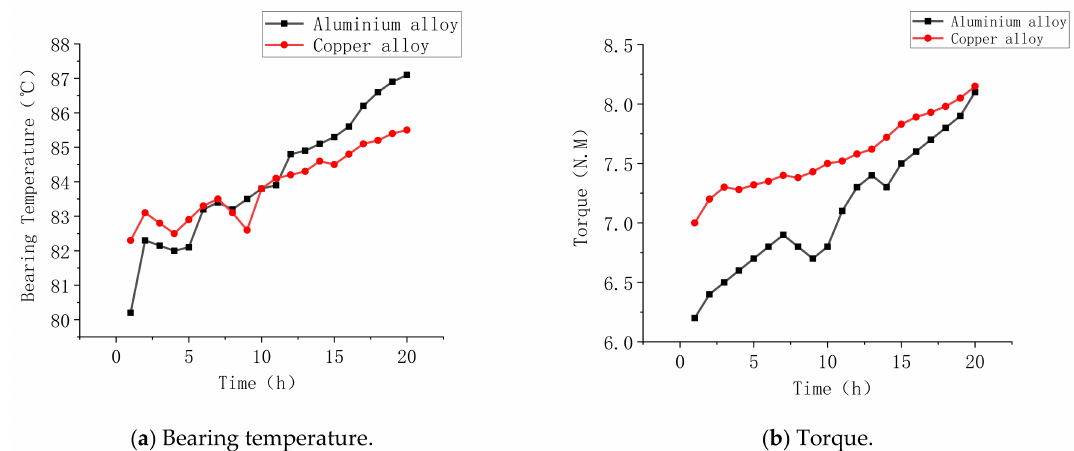
Figure 13. Comparison of bearing lubrication parameters of different bearing shells with different wear test